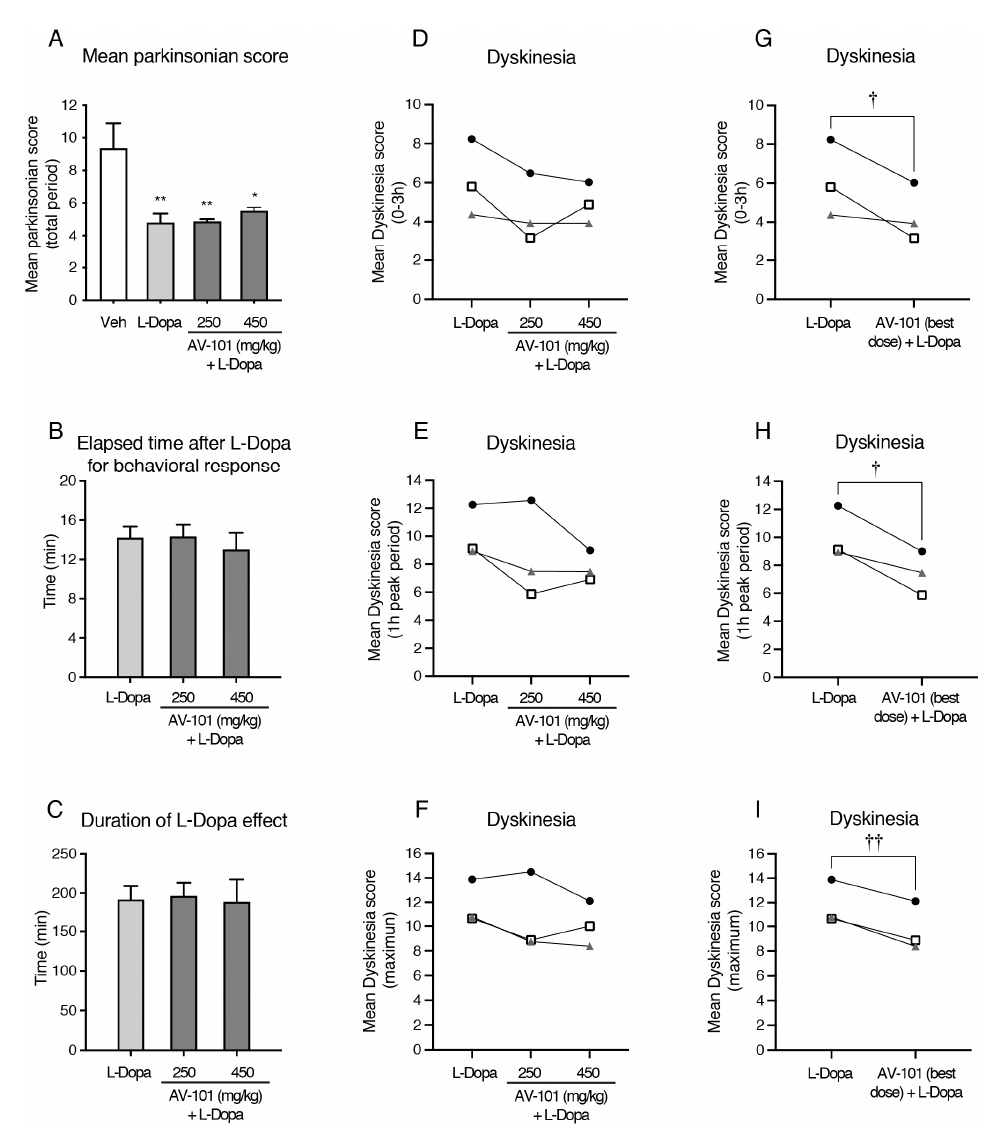
Figure 3. Effect of combination of AV-101 to L-Dopa on the dyskinesia score and antiparkinsonian response in a pilot study ( n = 3). ( A ) AV-101 maintained the L-Dopa antiparkinsonian response. ( B , C ) Delay of L-Dopa response and duration to L-Dopa effect were not affected by the AV-101 treatment. ( D – I ) Combination of AV-101 with L-Dopa reduced the mean dyskinesia scores. * p < 0.05 and ** p < 0.01 vs. Vehicle; † p ≤ 0.05 and †† p < 0.01 vs. L-Dopa.